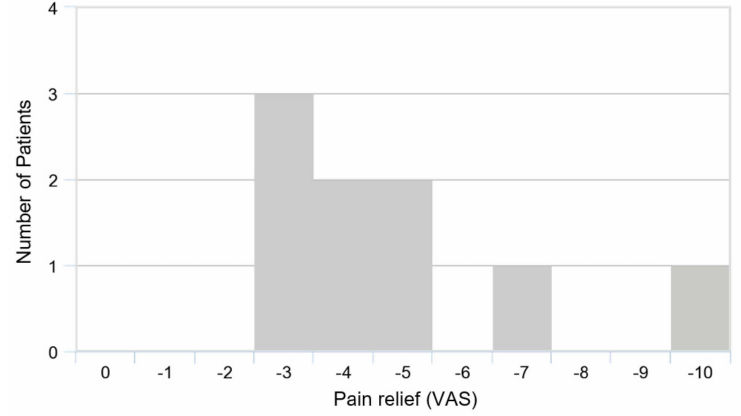
Figure 2. Pain relief in total, over a period of six months.